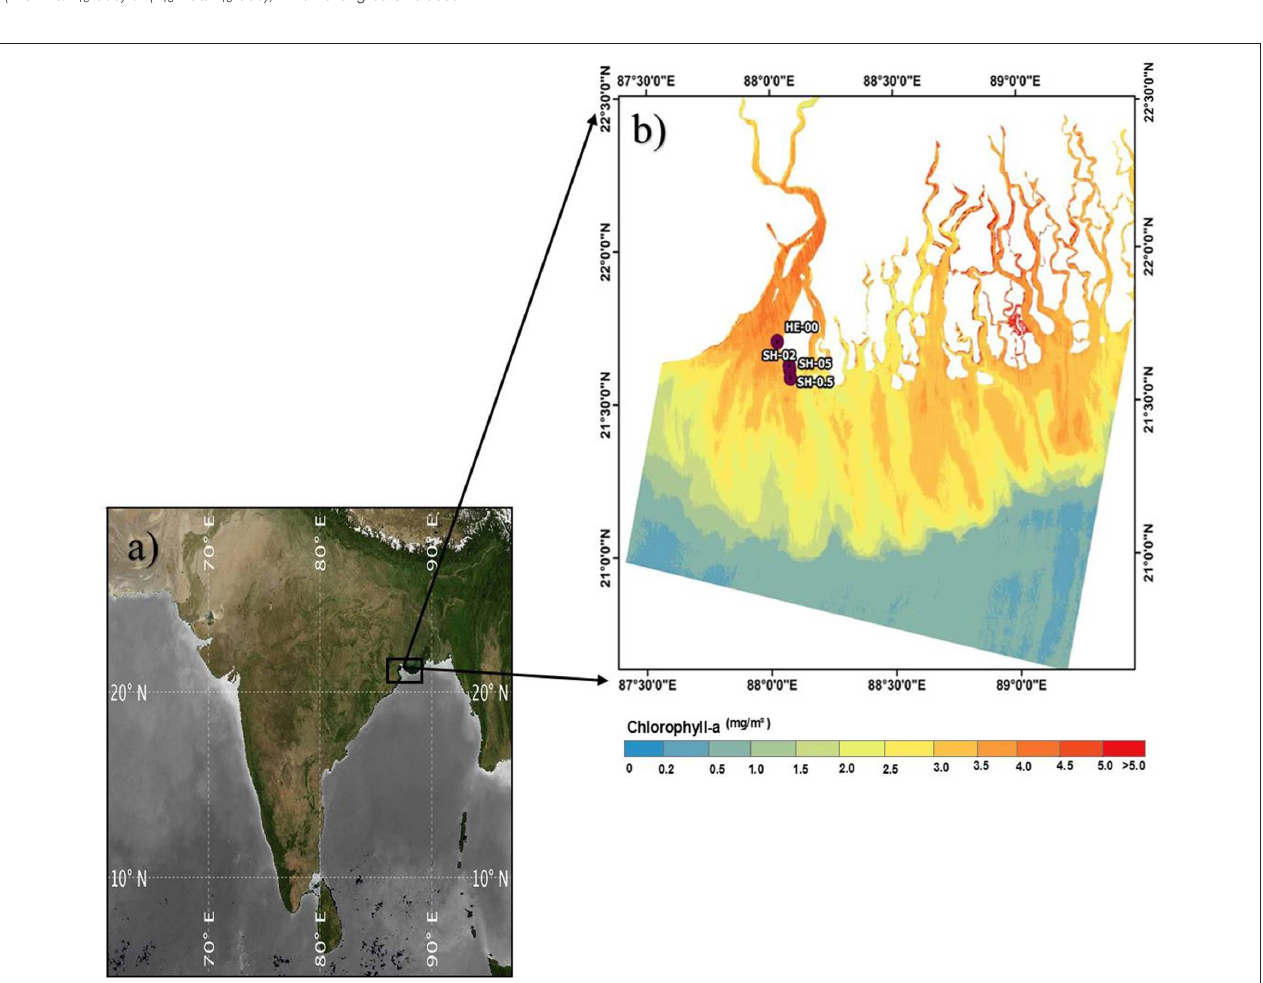
FIGURE 1 | Schematic of the study area: (a) The North Indian Ocean with the domain of interest marked (north coastal Bay of Bengal), (b) Magnified view highlighting the coastal features, locations of the COMAPS data stations, & pre-monsoon averages (2014–2017) of Chl-a retrieved from Landsat-8 OLI using OC-2 algorithm in the